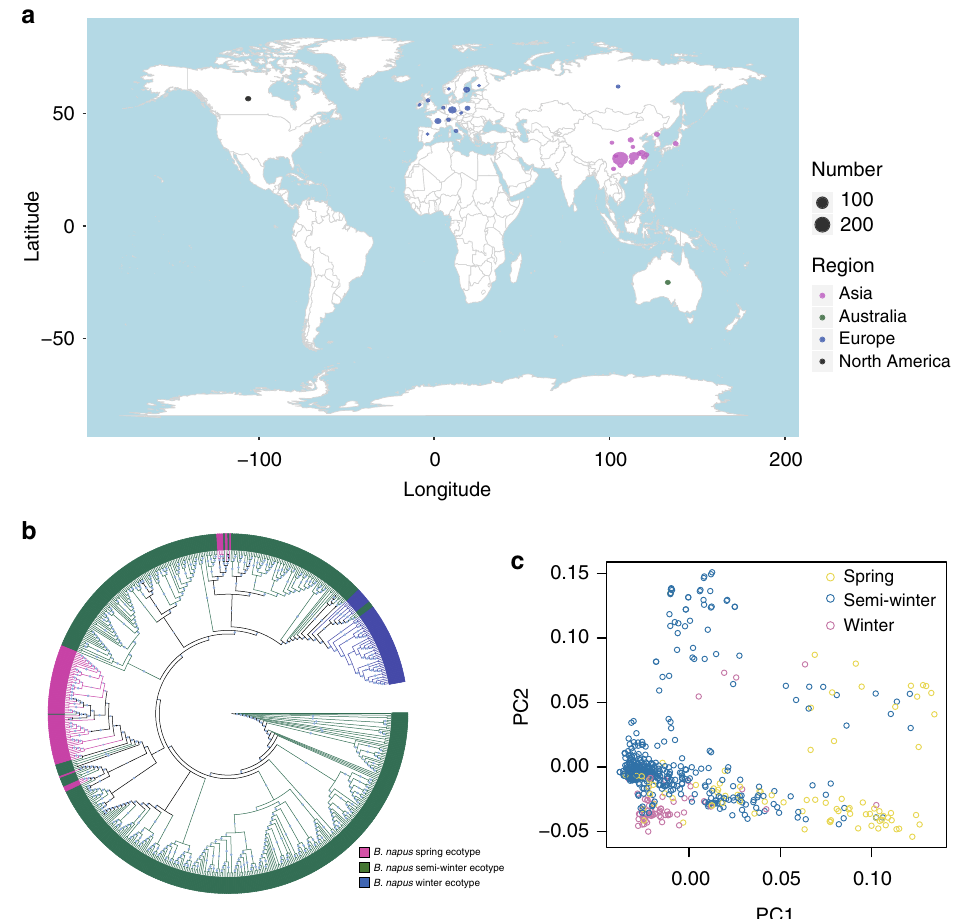
Fig. 1 Geographic distribution and population structure of B. napus accessions. a Geographic distribution of 588 B. napus accessions in the world. b ML tree of all B. napus accessions inferred from SNPs at fourfold-degenerate sites. Phylogenetic tree was constructed using IQ-TREE 19 with the best model GTR + F + ASC + R5. Clades with bootstrap values of above 50% are indicated by a circled blue dot. c PCA plot of all the B. napus accessions used in this study. a was generated in R (V3.2.5) using package rworldmap. Source data are provided as a Source Data fi